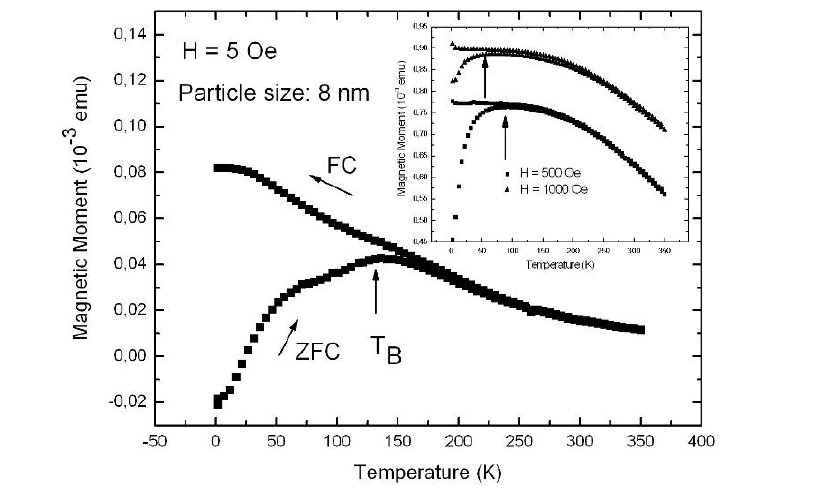
Figure 40. ZFC/FC measurements carried out at an applied magnetic field of 5 Oe and in a temperature range between 4.2 K and 360 K. The high blocking temperature (maximum peak of the ZFC-branch) at 135 K indicates dipolar coupling between the particles. Inset: Shift of T towards lower temperatures with increasing applied magnetic field (reproduced B by permission of The Electrochemical Society [131]).